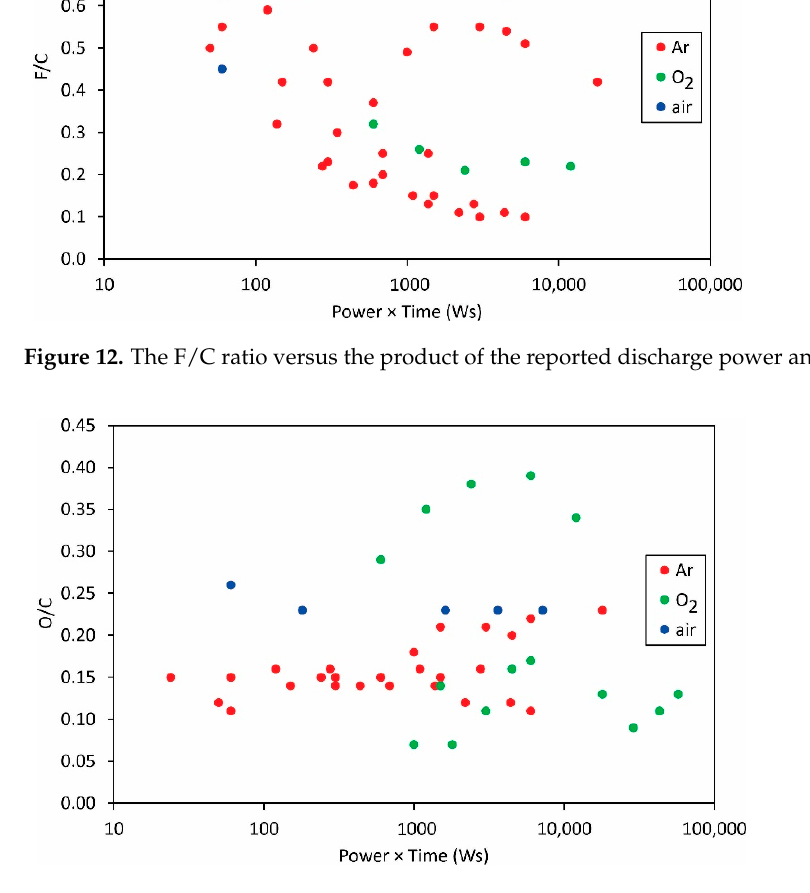
Figure 13. The O/C ratio versus the product of the reported discharge power and treatment time.